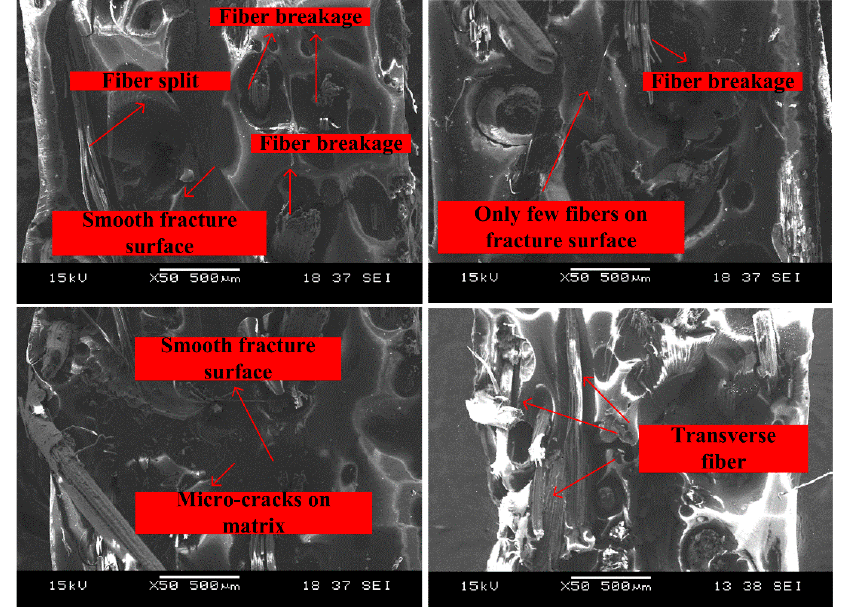
Figure 9. Fracture morphologies of APB under quasi-static conditions.